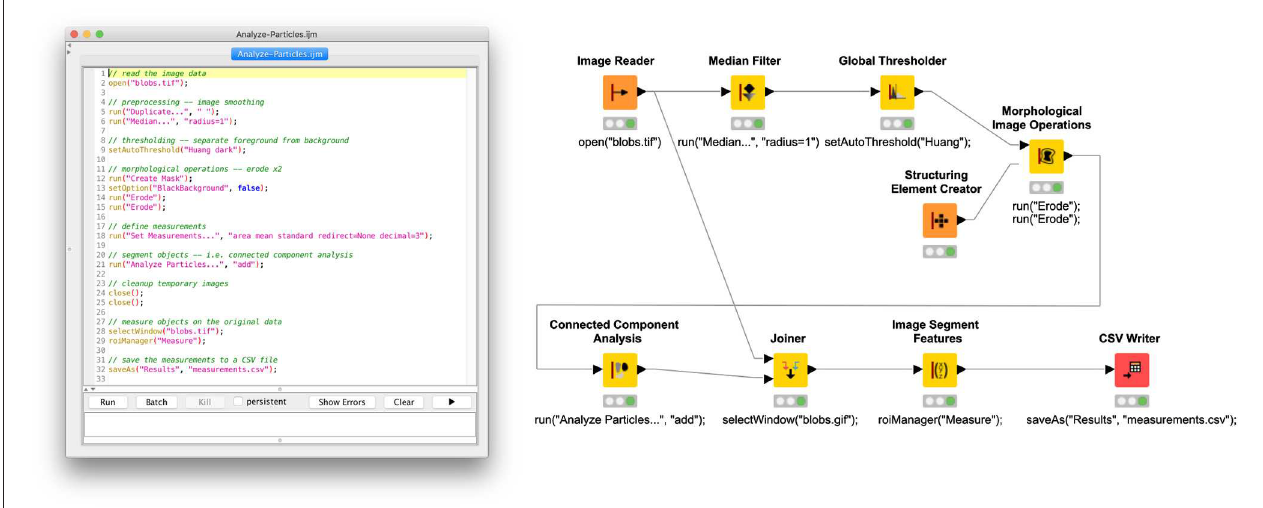
FIGURE 4 | Side-by-side comparison of ImageJ macro with KNIME workflow using KNIME Image Processing